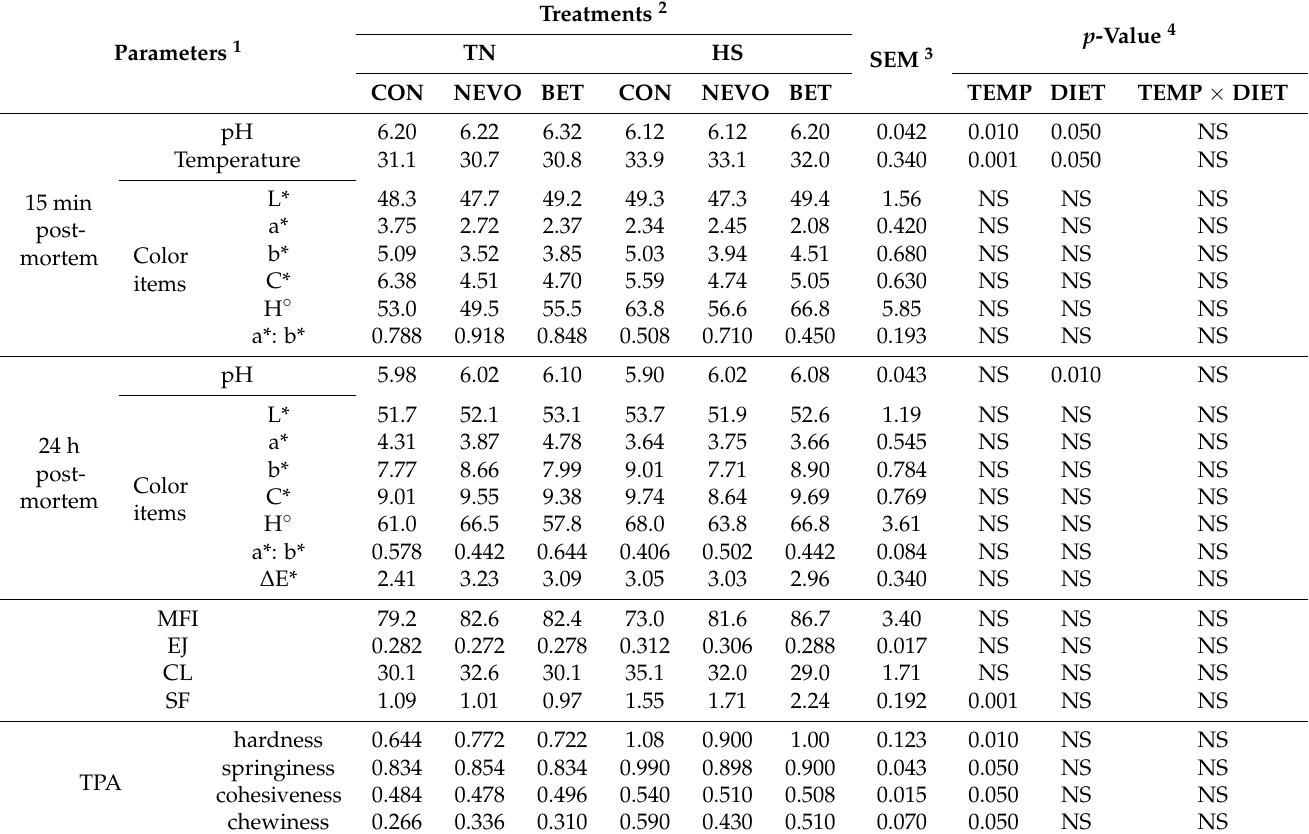
Table 4. Effect of the treatments on meat quality of pectoralis major muscles of broiler chickens sampled at 35 d.